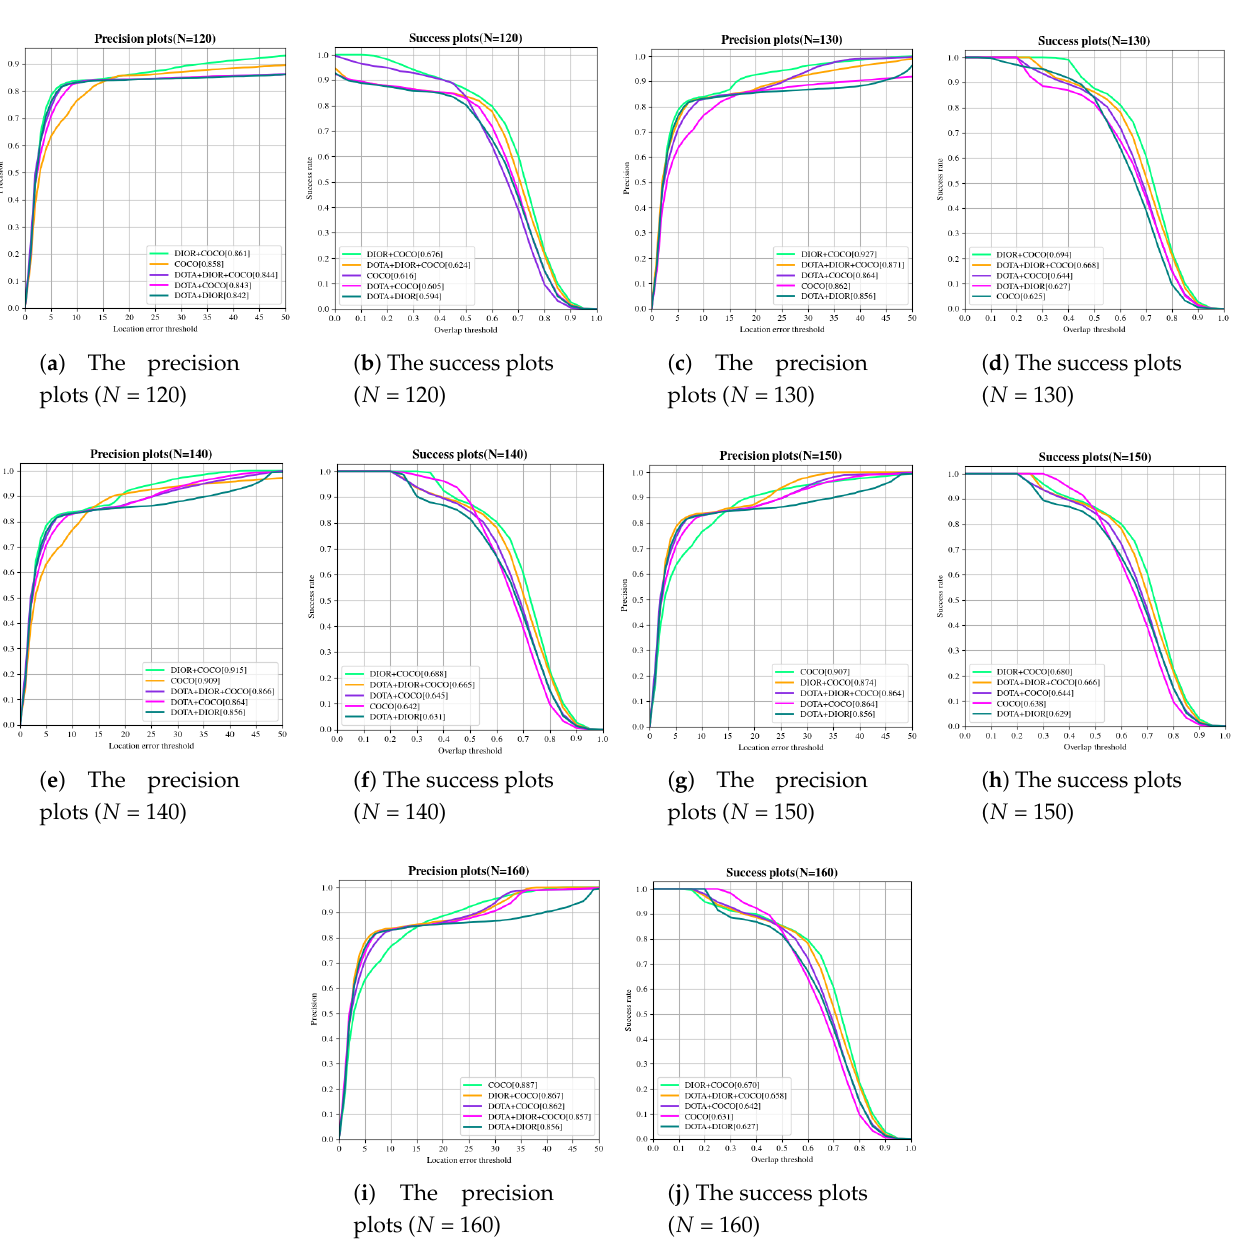
Figure 7. The precision plots and success plots when N is assigned different